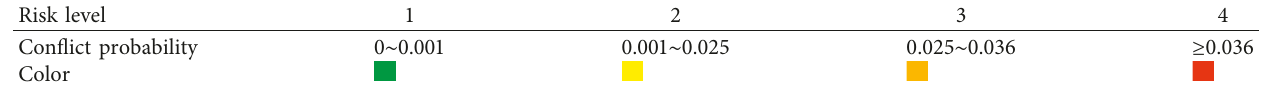
Table 1: Risk level